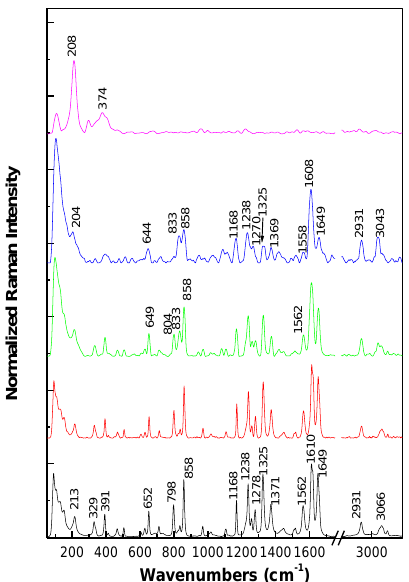
Figure 6. The Raman spectrum of AC (black curve). Red, green and blue curves correspond to the Raman spectra of AC interacted with NaOH, and subsequently exposed to UV light for 140 min, when the AC: NaOH weight ratio is equal to 4.2, 0.5 and 0.4, respectively. Magenta curve corresponds to the Raman spectrum of NaOH.